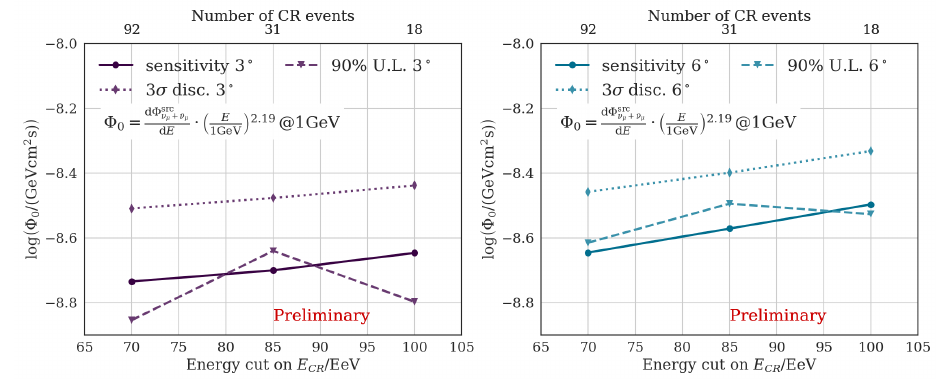
Figure 2. Experimentally obtained limits on the neutrino flux per source for each of the tested signal hypotheses, compared to sensitivity and 3 σ discovery potential of the same signal